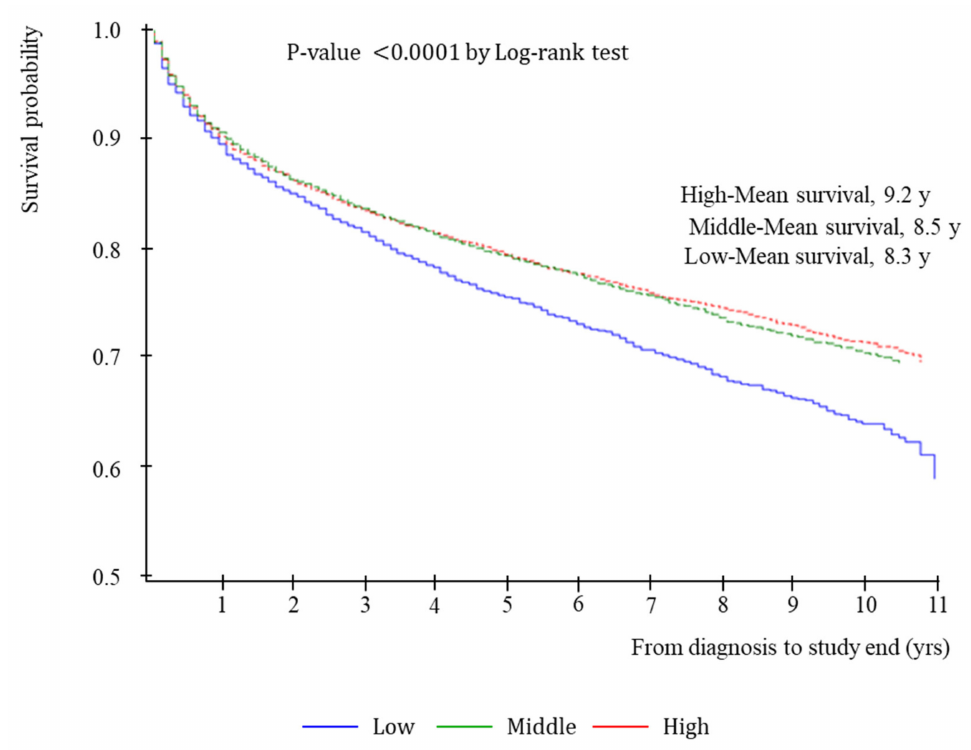
Figure 2. Individual household income stratified survival probability for all-cause mortality. Individuals with low income in a disadvantaged location had an average of 8.3 mean years of survival, whereas those with low income in an advantaged area had an average of